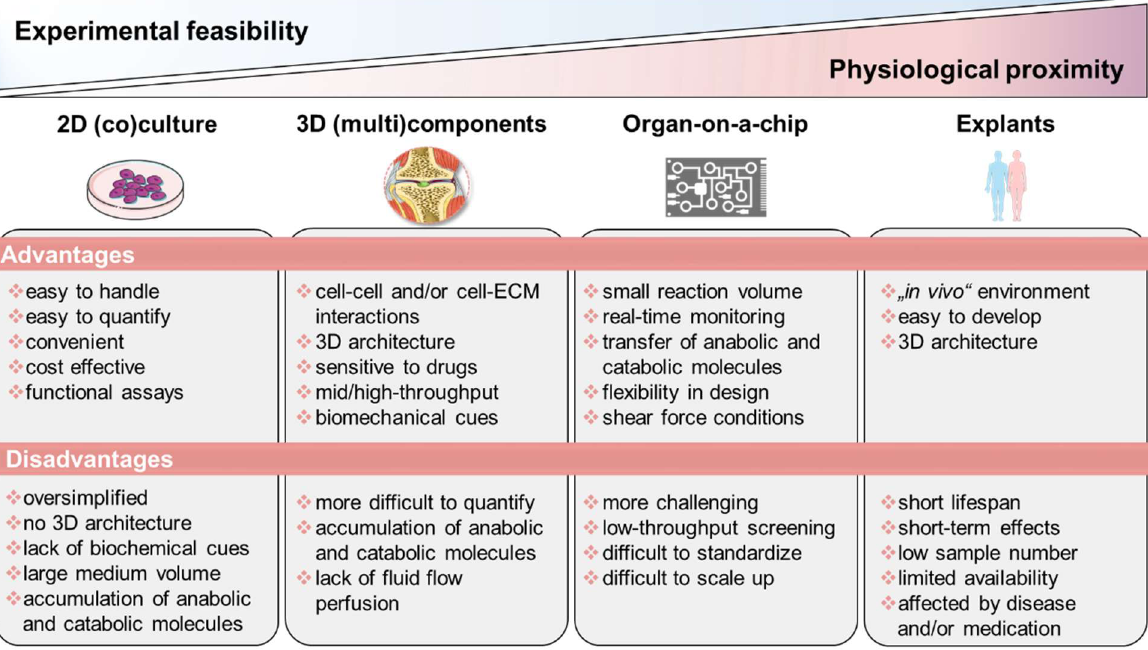
Figure 2. Overview of state-of-the-art in vitro models classified according to experimental feasibility and physiological proximity. Figure contains graphics from Servier Medical Art, licensed under a Creative Common Attribution 3.0 Generic License. http://smart.servier.com/